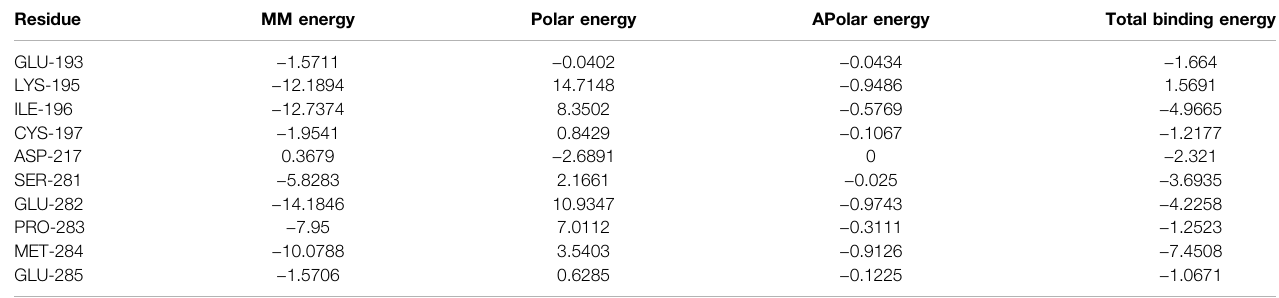
TABLE 1 | Energy contribution of the amino acid residues in quercetin-NF- κ B p65 complex (kcal/mol). Residue